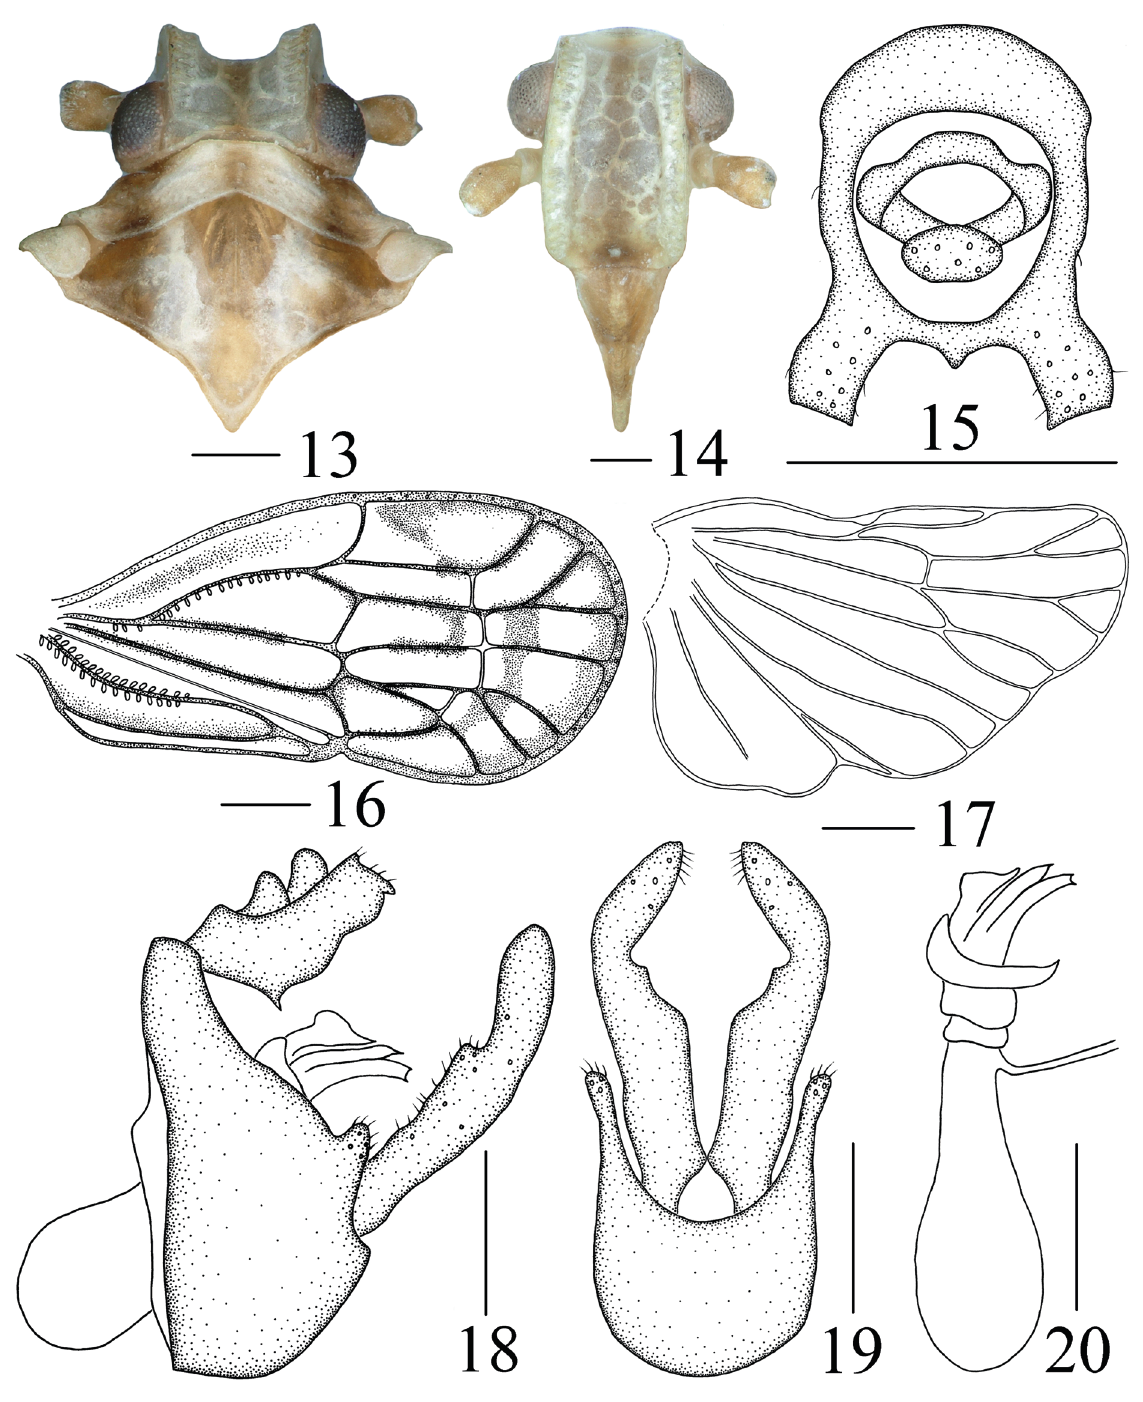
Figs 13–20. Eponisiella shandongensis sp. nov., ♂ , holotype (IEGU). 13 . Head and thorax, dorsal view. 14 . Frons, ventral view. 15 . Anal tube, dorsal view. 16 . Tegmina. 17 . Wing. 18 . Pygofer, lateral view. 19 . Gonostyli and pygofer, caudoventral view. 20 . Aedeagus, left lateral view. Scale bars: 13–15, 18–20 = 0.2 mm; 16–17 = 0.5